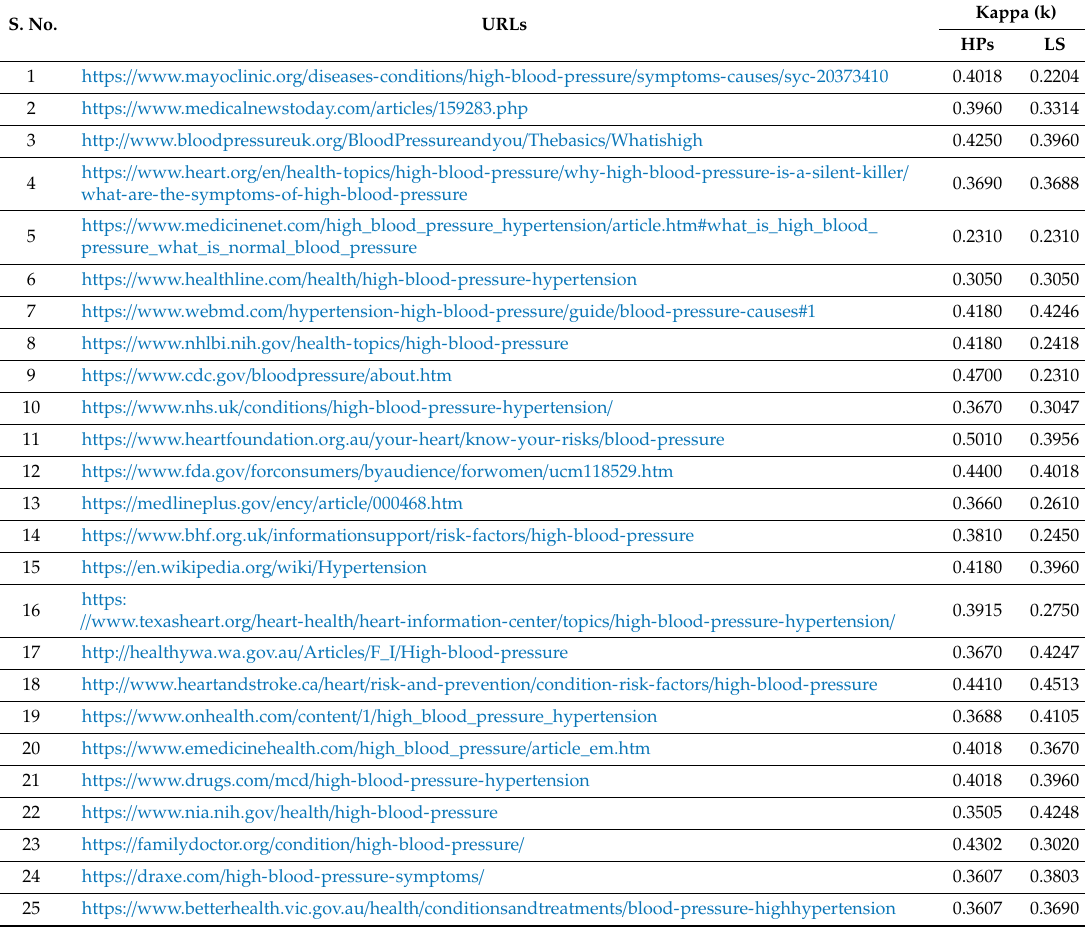
Table A1. Unique Websites and Corresponding Kappa